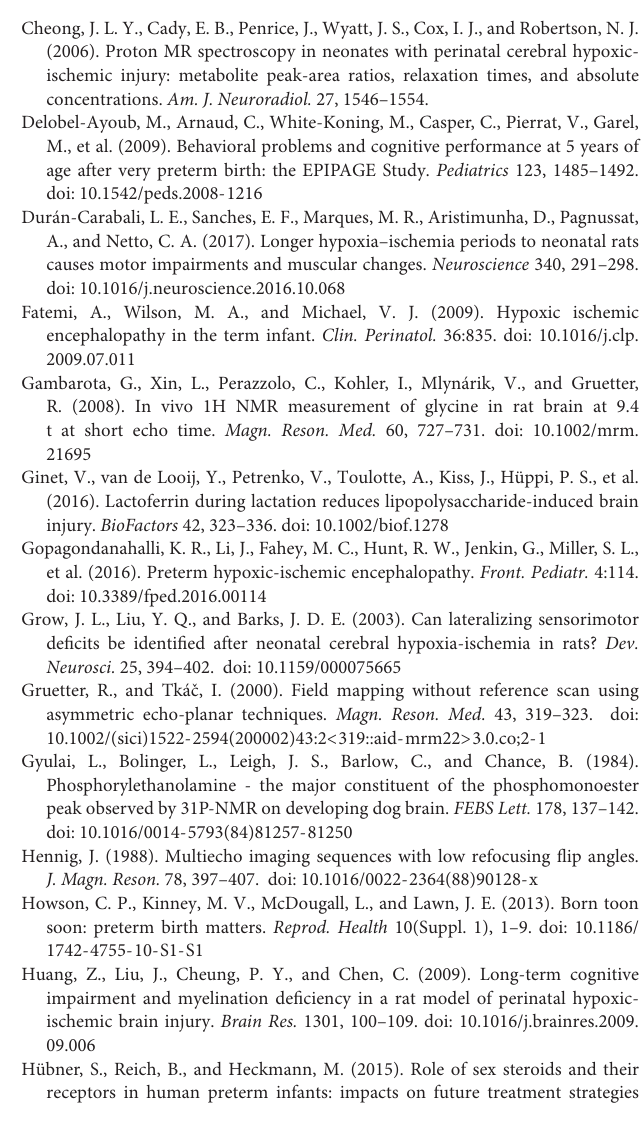
FIGURE S1 | Original western blotting runs. Note that only the 7 ladders localized in the left side of the gels were used in the study ( n = 6–8 animals/group). Antibodies used in the study were NeuN (a) , GFAP (b) , β III Tubulin (c) , and MBP (d) . FIGURE S2 | Metabolite concentrations in the brain cortex (R: right and L: left) after neonatal HI compared to the sham-operated animals (SH). Metabolite abbreviations were presented in the Methods section. No substantial differences were observed. TABLE S1 | Antibodies used in the study. DATA SHEET S1 | The raw data of typical western blotting